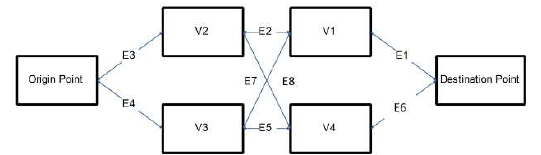
Figure 2. The directional graph between origin and destination points.